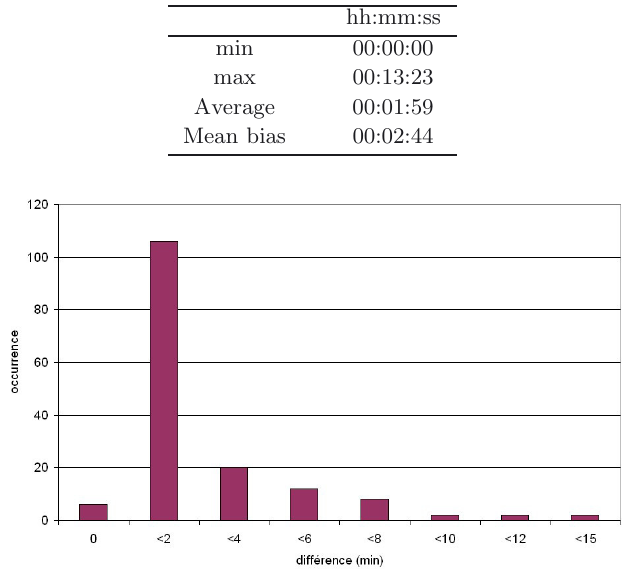
Fig. 6. Distribution of temporal accuracy: occurrence as a function of